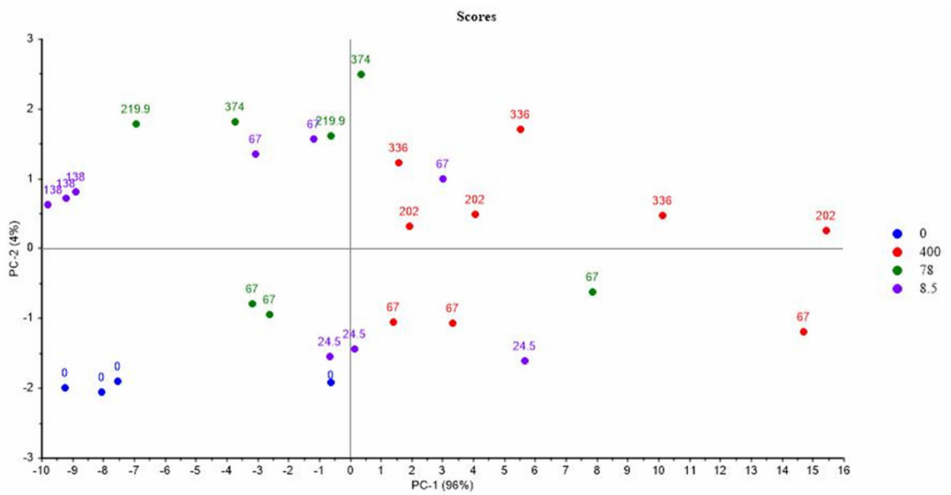
Figure 5. PCA results on Mod3: UJV irradiation dose rate (Gy/h) with location of the second step of